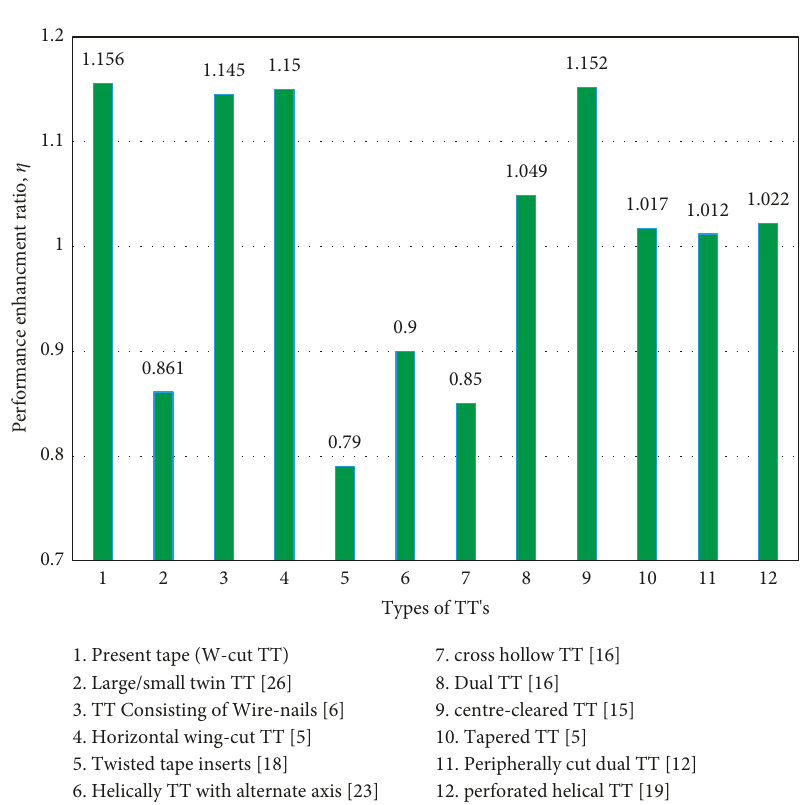
Figure 18: Performance comparison of optimal configuration WCTT with former